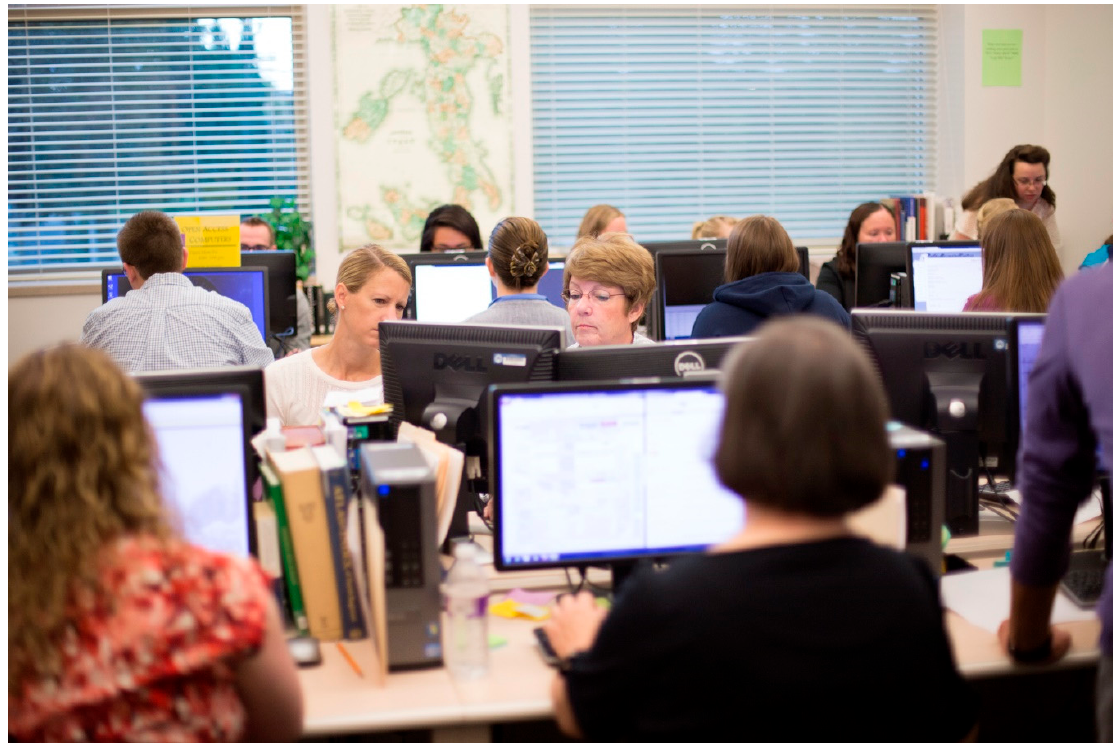
Figure 4. Students working in the BYU Center for Family History and Genealogy.